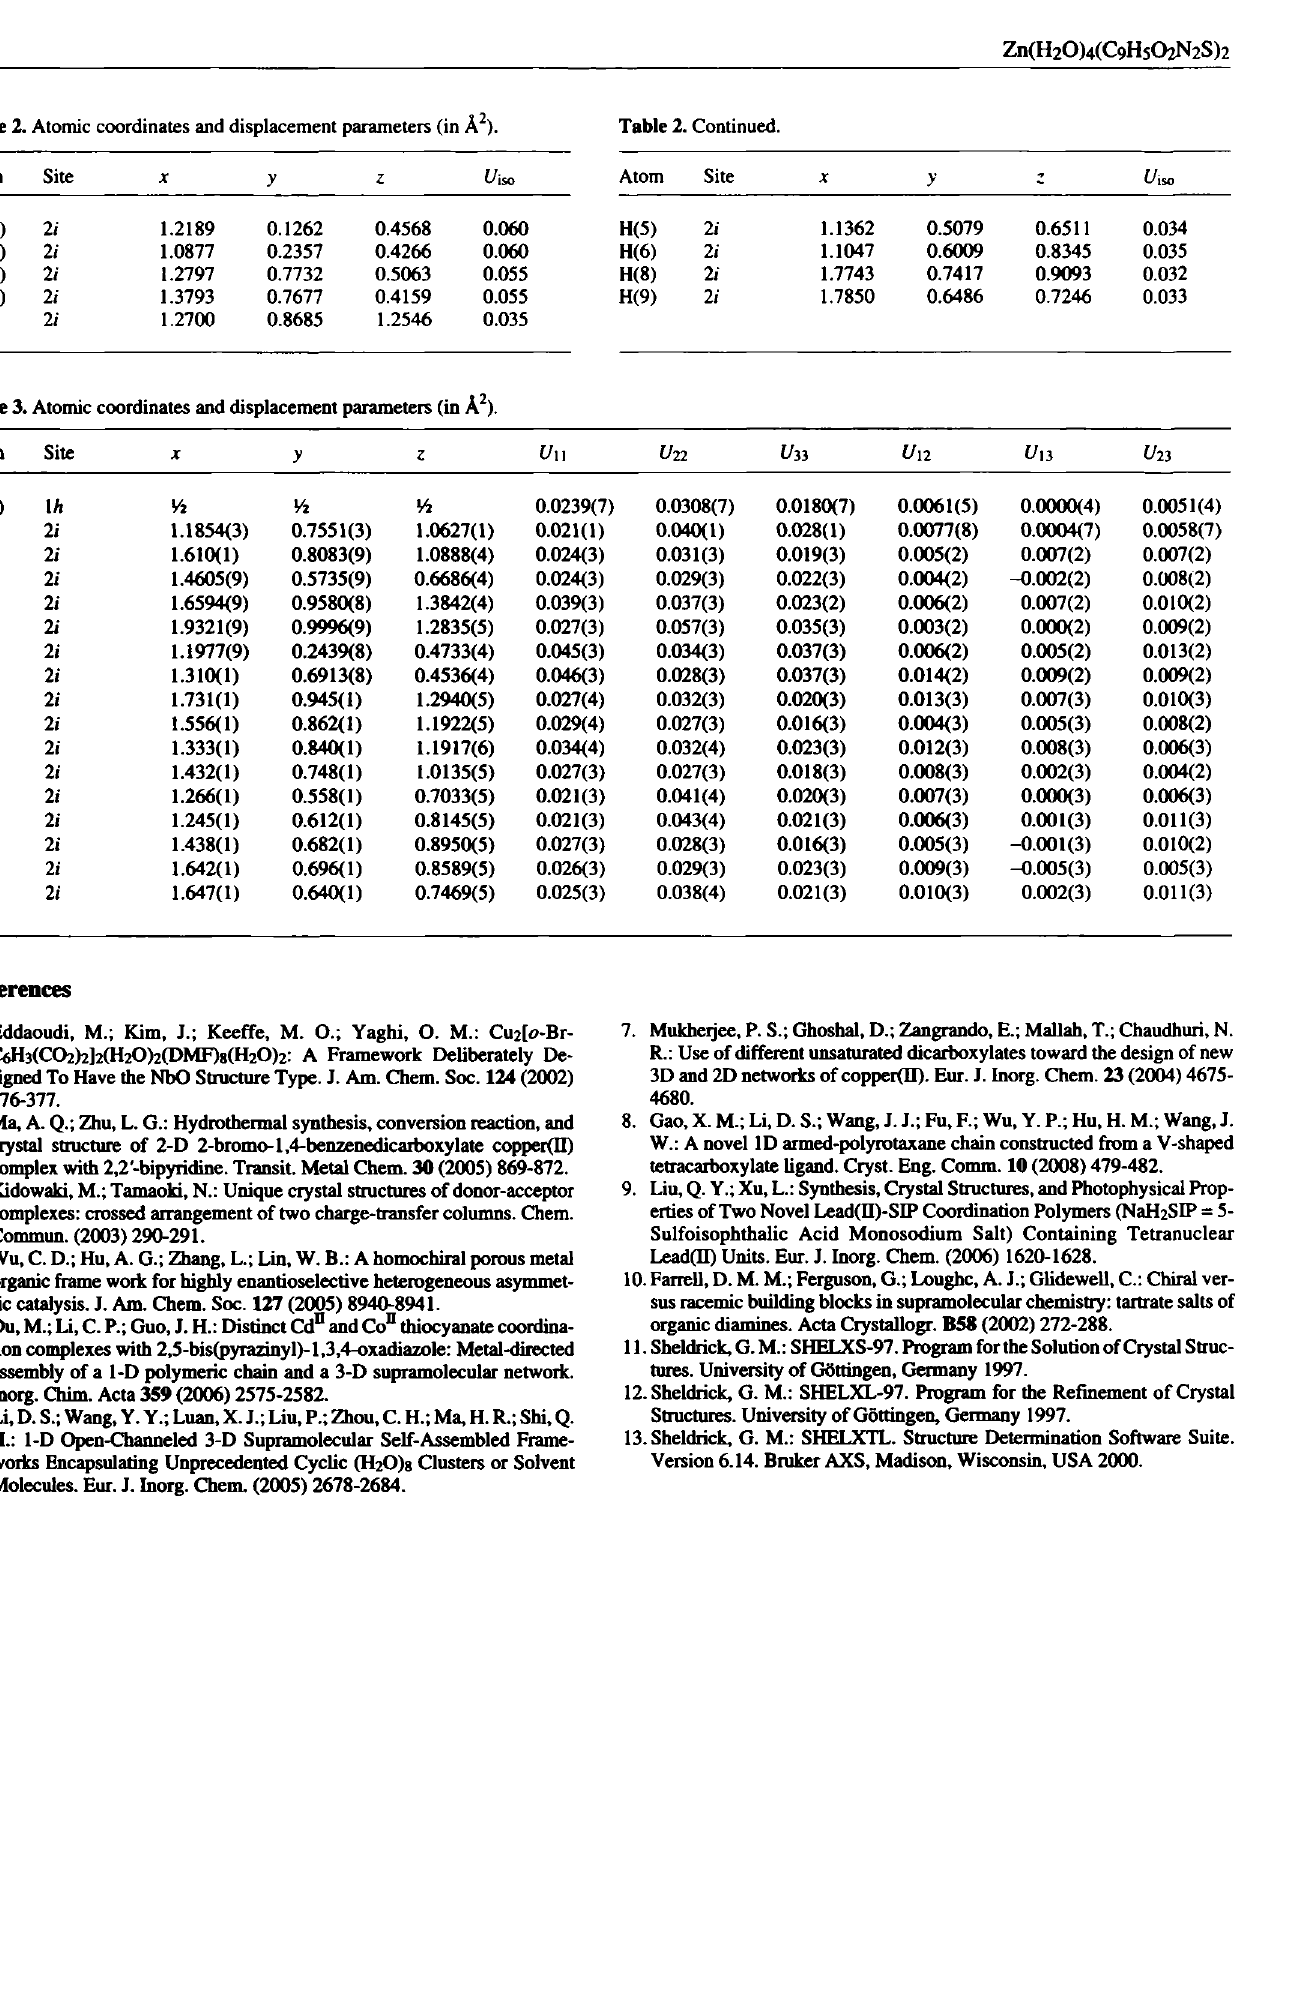
Table 2. Atomic coordinates and displacement parameters (in À 2 ). Table 2. Continued.